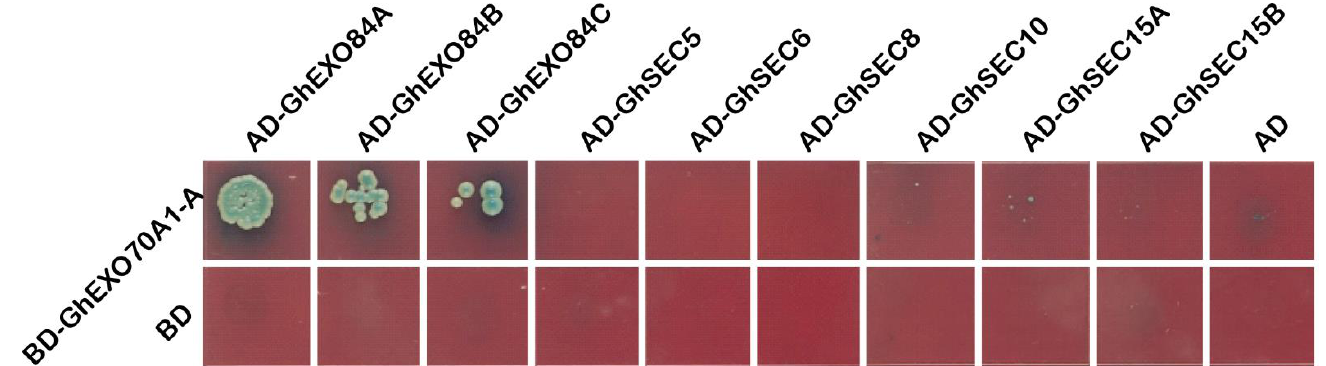
Figure 7. Y2H analysis of interactions among GhEXO70A1-A and other exocyst subunits. GhEXO70A1-A is connected to